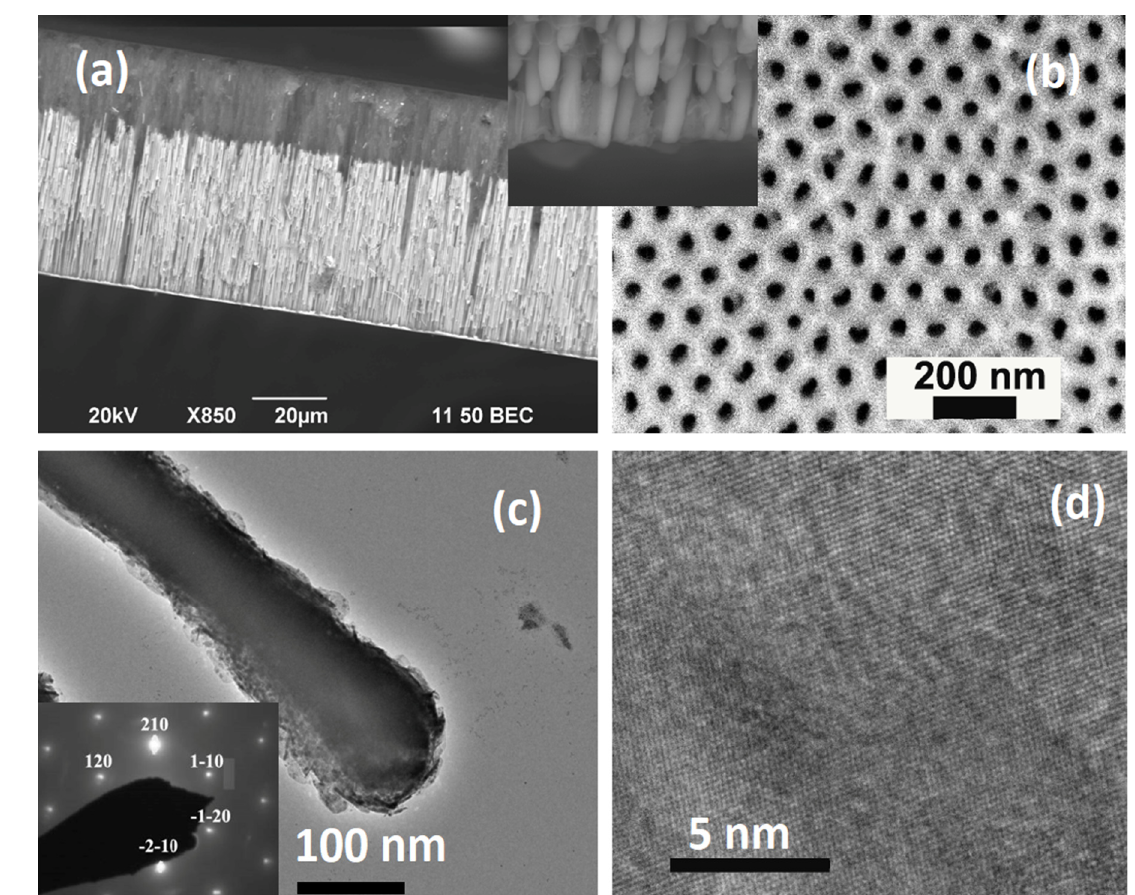
Figure 2. SEM image of AAO template ( a ) cross-sectional and ( b ) top view. Bright field TEM image of one the wires; scalebar 200 nm ( c ) along with selected area diffraction and ( d ) high-resolution TEM with d-spacing (2.03 Å) corresponds to (200) planes of hcp Co.